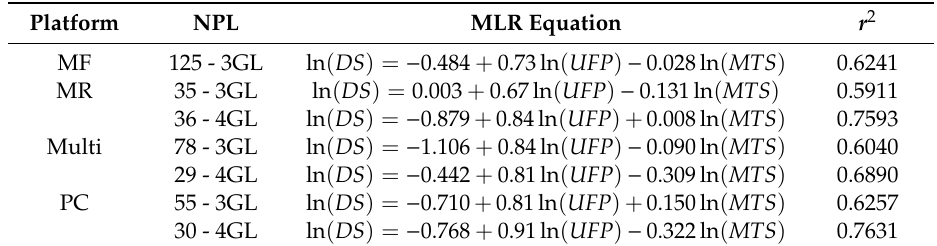
Table 3. Coe ffi cient of determination r 2 by multiple linear regression (MLR) by data set (NPL: number of projects and PL).